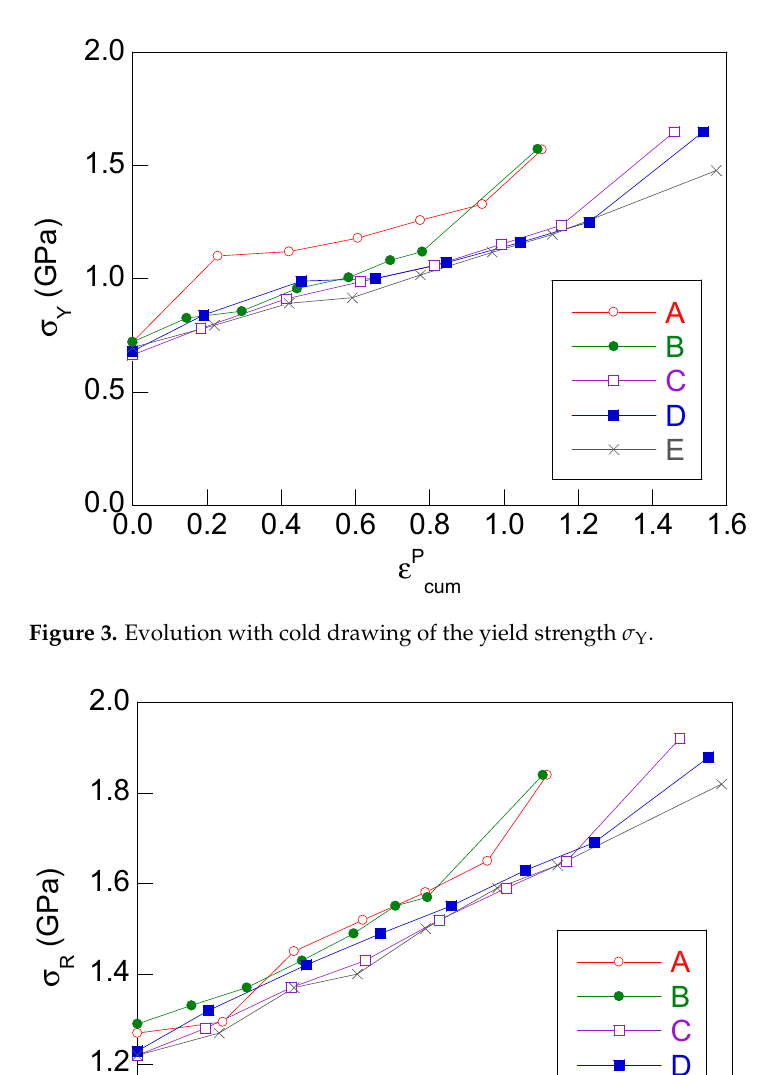
Figure 4. Evolution with cold drawing of the ultimate tensile strength σ R